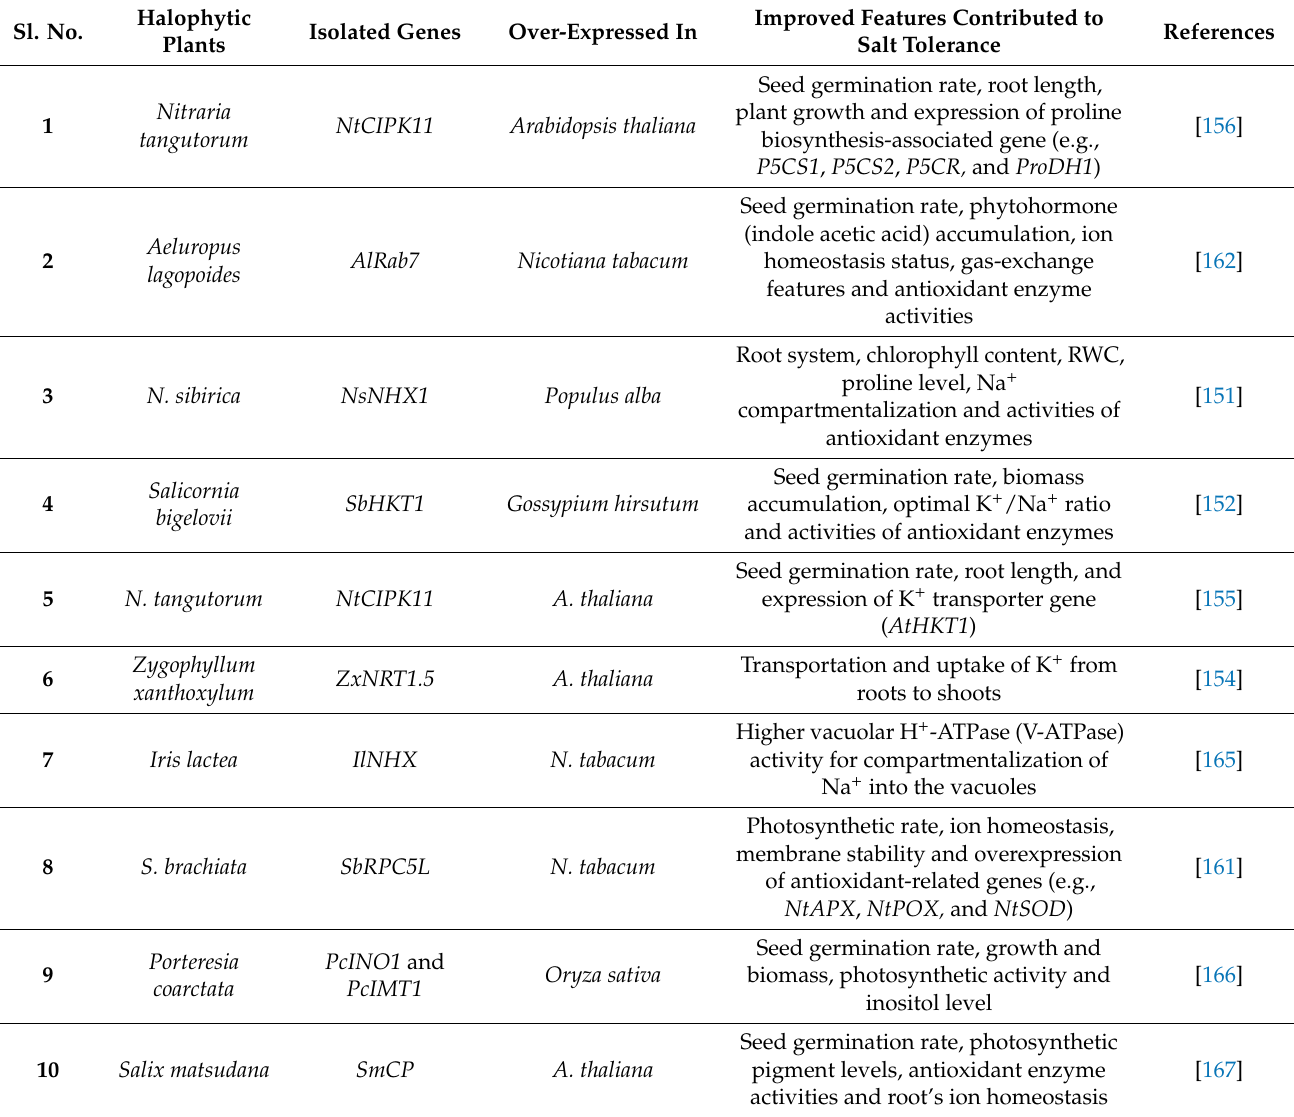
Table 2. Improvement of salt tolerance in plants by overexpressing various genes isolated from different halophytes. Sl.